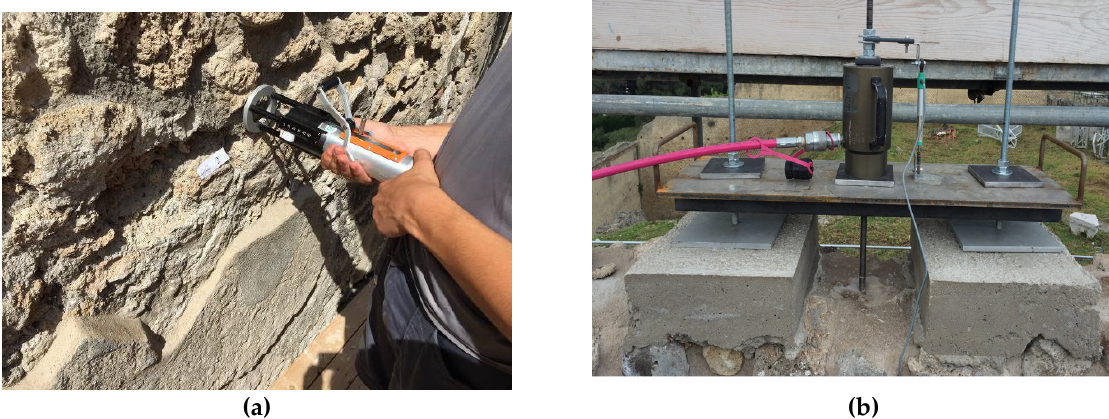
Figure 8. Tests. ( a ) Penetration test on mortar; ( b ) Pull-out test on a steel bar, connection the roof on the masonry walls. Table 3. Penetration test results on mortar.